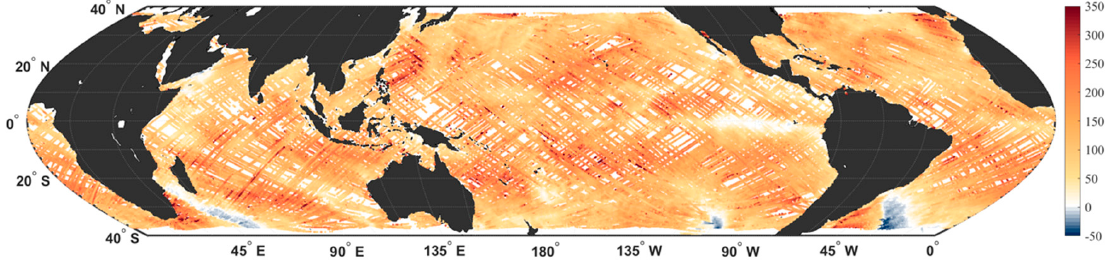
Figure 5. Full day of latent heat flux (W/m 2 ) observations on 30 August 2020 from the CYGNSS L2 Ocean Surface Heat Flux CDR v1.0 product.